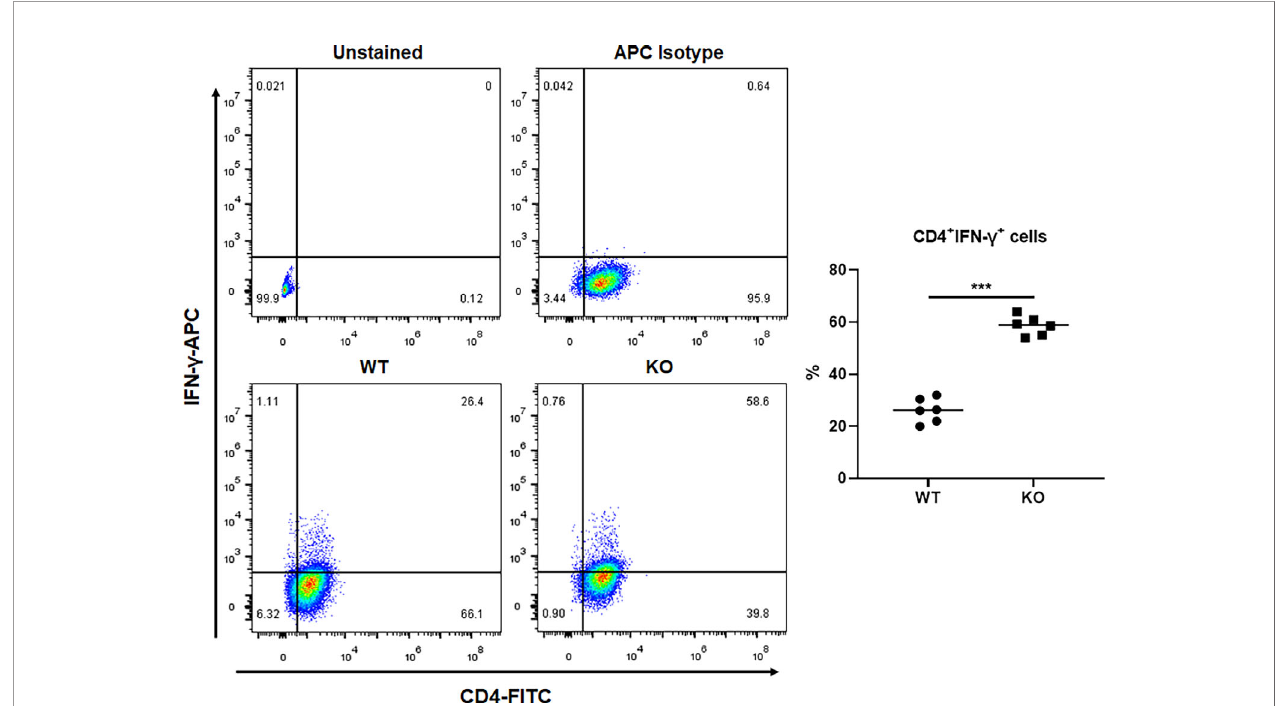
FIGURE 1 | Flow cytometry analysis of percentages of Th1 cells differentiated from WT and KO naïve CD4 + T cells. Data were analyzed by unpaired t -test and shown as the means ± SD ( n =6). ***P